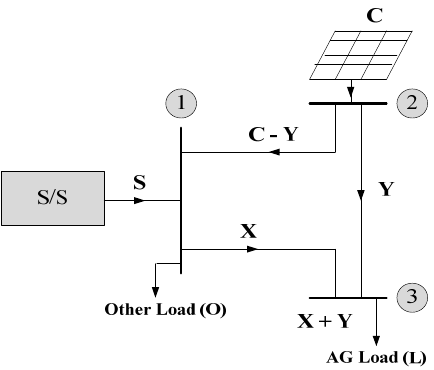
Figure 7 represents the Power Flow of AG feeder from the Grid distribution system and solar panel.